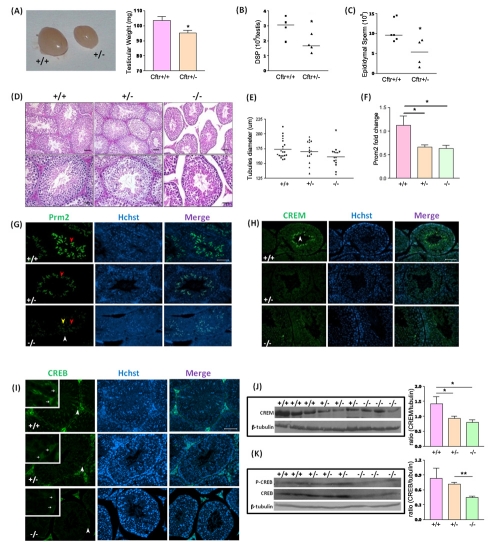
Defective spermatogenesis and altered expression of CREB in CF mice
testis.(A) Significantly reduced testis size and weight seen in
heterozygous S489X mice compared with wild-type mice
(n = 3; *:p<0.05). (B) Reduced
daily sperm production (DSP) values retrieved from heterozygous S489X
testes (n = 4; *:p<0.05). (C)
Reduced sperm numbers recovered from the epididymis of heterozygous
S489X mice (+/+ n = 6, +/−
n = 4; *:p<0.05). (D) H&E
staining of the cross sections of wild−type,
heterozygous and homozygous S489X CF mice testes. Seminiferous tubules
remain intact in +/− and −/− CF mice, but looser
tubule contacts with larger interstitial space are observed in
−/− testes (right) when compared with wild type (left).
Leydig cells and peritubular myloid cells are detached from most tubules
in −/− testes. Bar  = 20 µm
(upper panel) or 50 µm (lower panel). (E) Statistic
shows slight decrease in tubular diameter is observed in −/−
testes. (F) Realtime PCR of protamine-2 in S489X CF mice
testes. Protamine-2 mRNA level is significantly lowered in heterozygous
and homozygous S489X CF mice compared to their wildtype littermates.
(G) Immunofluorescent staining of Protamine-2 in
+/+, +/− and −/− S489X CF mice testes
(stage VII–VIII). In +/+ testes, Protamine-2 positive
signals are located in elongated spermatids (ES) with strong
immunoreactivity (red arrow). In +/− testes, Protamine-2 is
found in ES with moderate immunoreactivity (red arrow). In
−/− testes, there is weak intensity in the pachytene
spermatocytes (P) (white arrow), ES (red arrow) and round spermatids
(RS) (yellow arrow). Bar  = 50 µm.
(H) Immunofluorescent staining of CREM in S489X CF mice
testes (stage VIII–I). In wild-type testes, CREM positive signals
are localized in RS (white arrow), with strong immunoreactivity. In
+/− and −/−testis, CREM showed weak
immunoreactivity. Bar  = 50 µm.
(I) Immunofluorescent staining of CREB in S489X CF mice
testes shows stronger immunoactivity in +/+ and +/−
mice Sertoli cell compared to that of −/−. Bar
 = 50 µm. (J) Western blot
analysis of CREM expression in S489X CF testes. CREM expression is
decreased in +/− and −/− testes compared to
wild-type (n = 3; *:p<0.05).
(K) Western blot analysis of CREB expression in S489X CF
testes. CREB expression is decreased in −/− testes compared
to +/− and wild-type (+/+
n = 2, +/− and −/−
n = 3; **:p<0.01). Statistic data are
shown as mean±SEM.